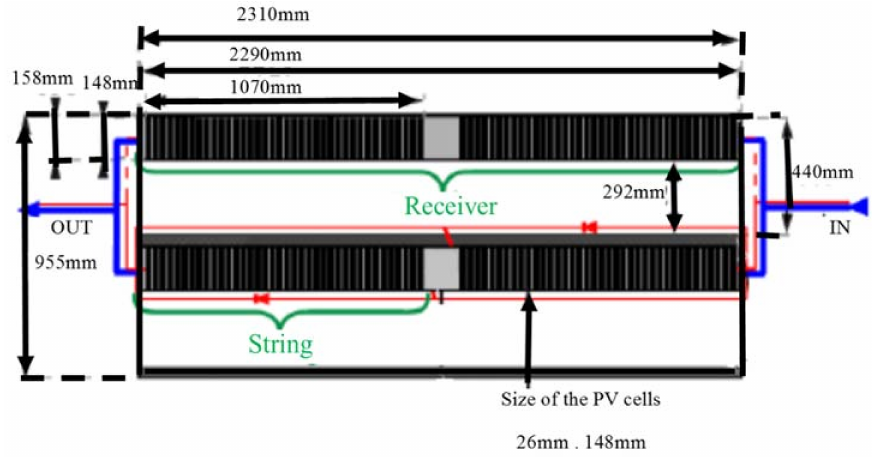
Figure 8. Top view of the photovoltaic thermal (PVT) Solarus AB